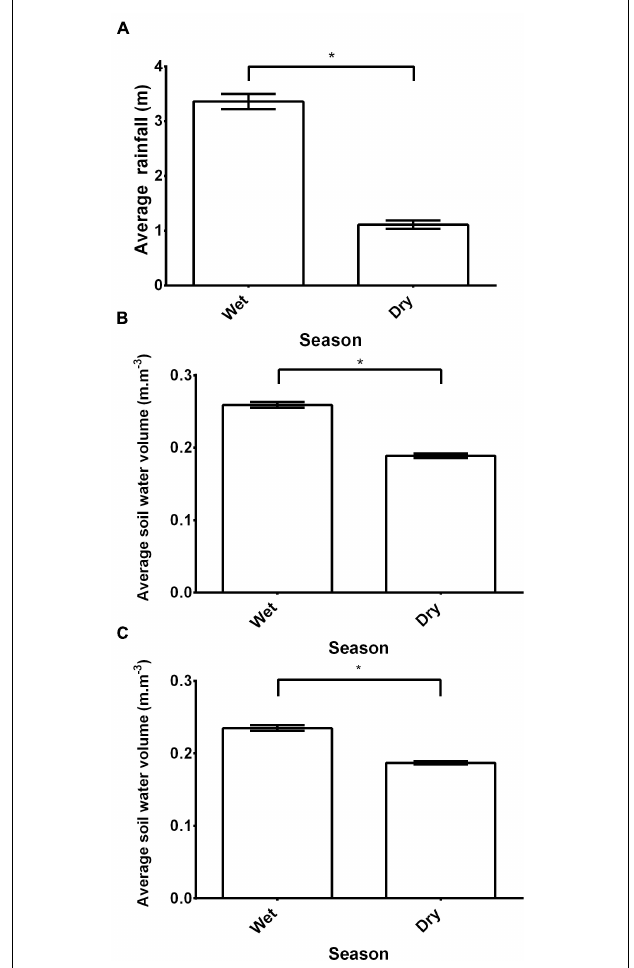
FIGURE 1 | The seasonal variation [(wet: December to March) or dry: (April to November)] in (A) rainfall (m) and soil volumetric moisture (m.m − 3 ) at (B) 0–7 cm and (C) 7–27 cm for the Pretoria Botanical Gardens (25 ◦ 44 (cid:48) 13.92 (cid:48)(cid:48) S, 28 ◦ 16 (cid:48) 24.24 (cid:48)(cid:48) E), Gauteng, South Africa. The climate variables was retrieved from ERA5-Land, a freely accessible dataset managed by the Copernicus Climate Change Service. Mean ± s.e.m. An asterisk (*) indicates significance ( p ≤